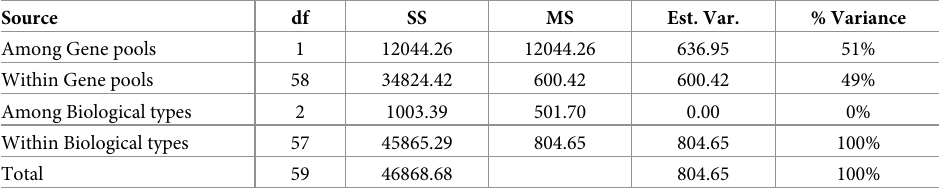
Table 9. Molecular analysis of variance of common bean populations based on 16,565 SNP markers. Source df SS MS Est. Var. % Variance Among Gene pools 1 12044.26 12044.26 636.95 51% Within Gene pools 58 34824.42 600.42 600.42 49% Among Biological types 2 1003.39 501.70 0.00 0% Within Biological types 57 45865.29 804.65 804.65 100% Total 59 46868.68 804.65 100% DF = degrees of freedom, E. variance = estimated variance, Gene pools = Andean or Mesoamerican, Biological types = breeding lines, landraces or released varieties.